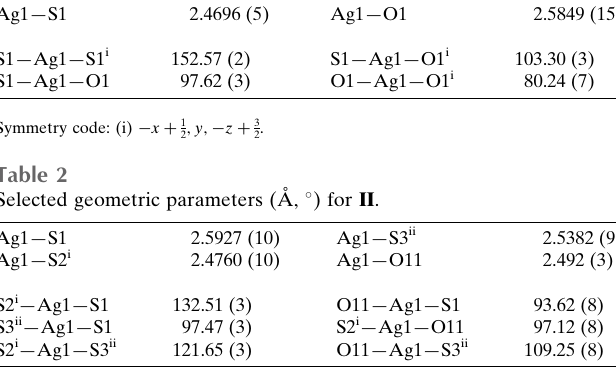
, (cid:4) z + 1 ); (iii) (cid:4) x , y + 1 2 2